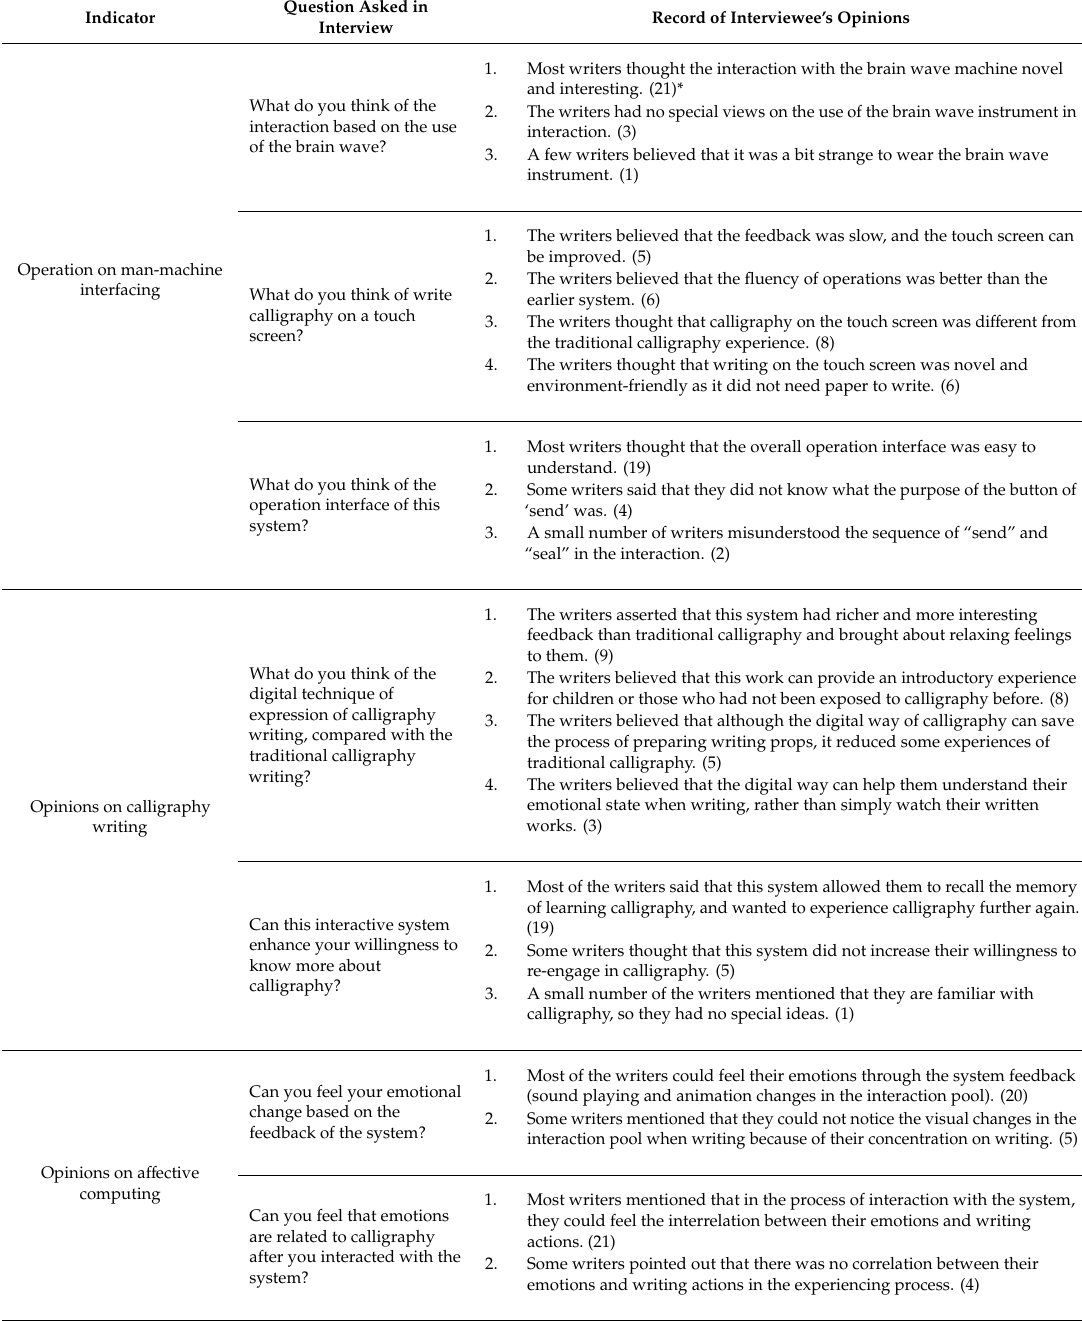
Table 22. Interview results obtained from the writers participating in the formal exhibition.